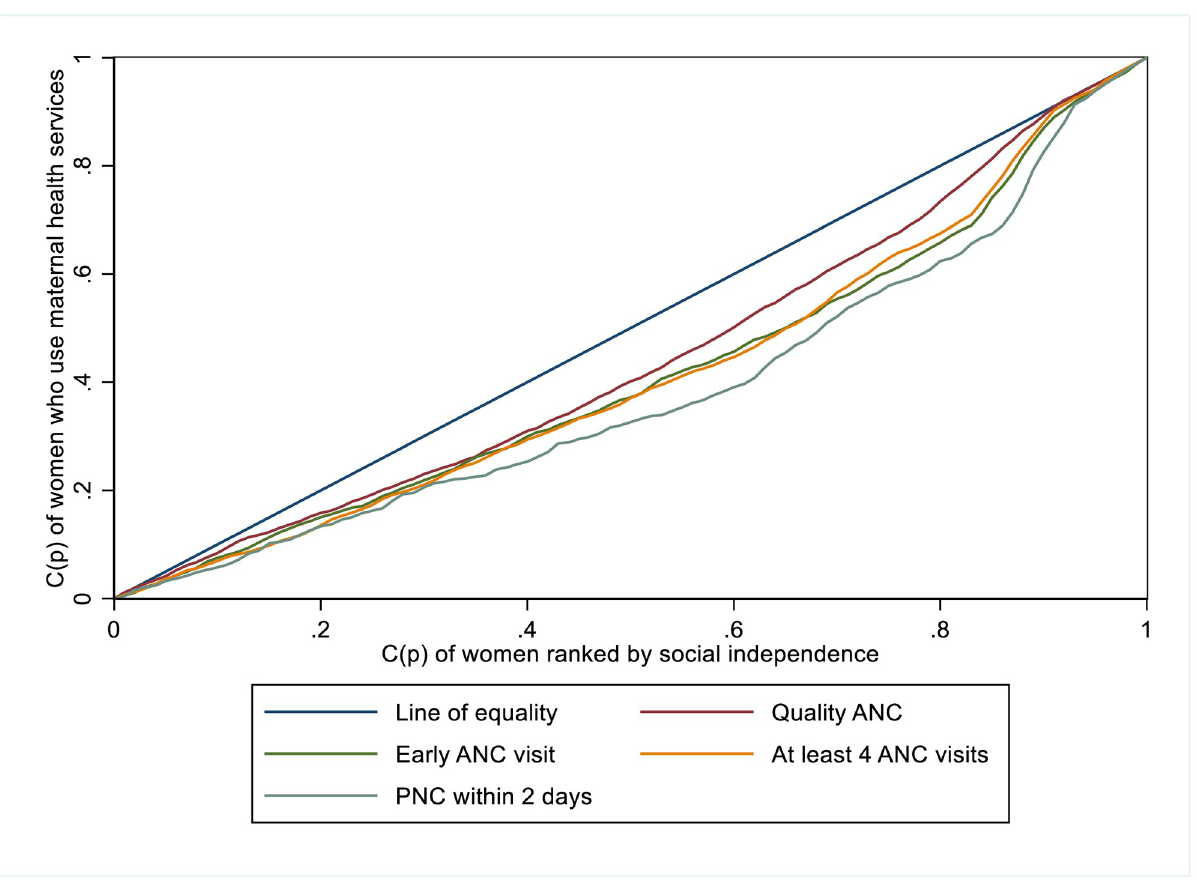
Fig 2. Concentration curves of maternal health services based on social independence domian of women’s empowerment. Note: C(p) refers to cumulative proportion.